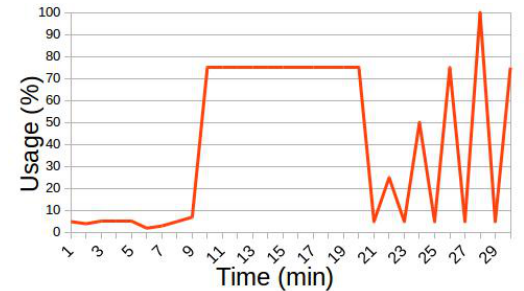
Figure 12. CPU evolution during evaluation of the tracks.